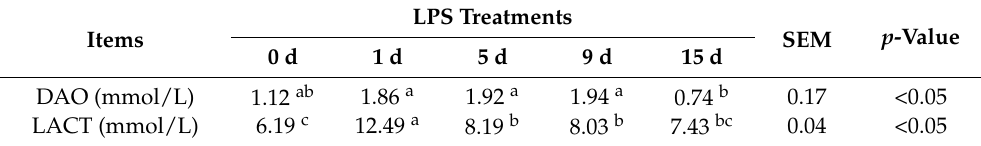
Table 3. Serum biochemical indices under LPS-induced chronic immune